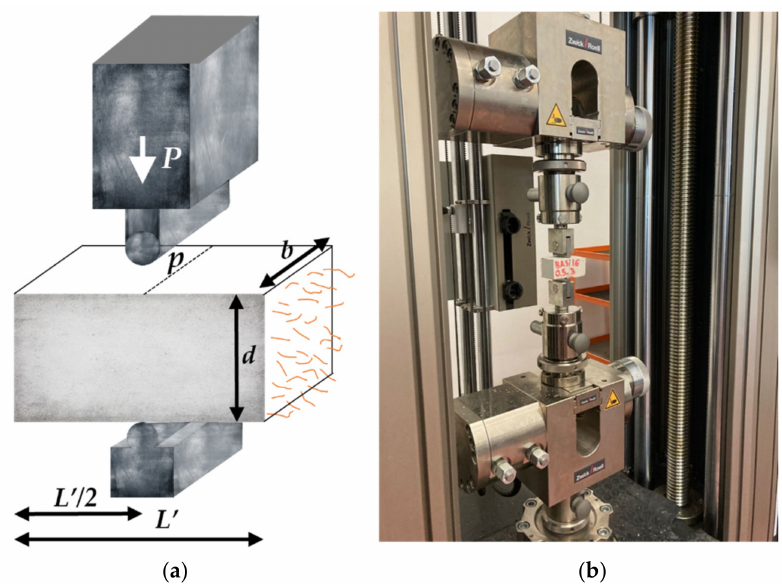
Figure 8. BT carried out at LPMS of L’Aquila. ( a ) First one-half specimen adopted in the tests; ( b ) setup of the specimen for the tensile test carried out with the Zwick Roell machine under displacement